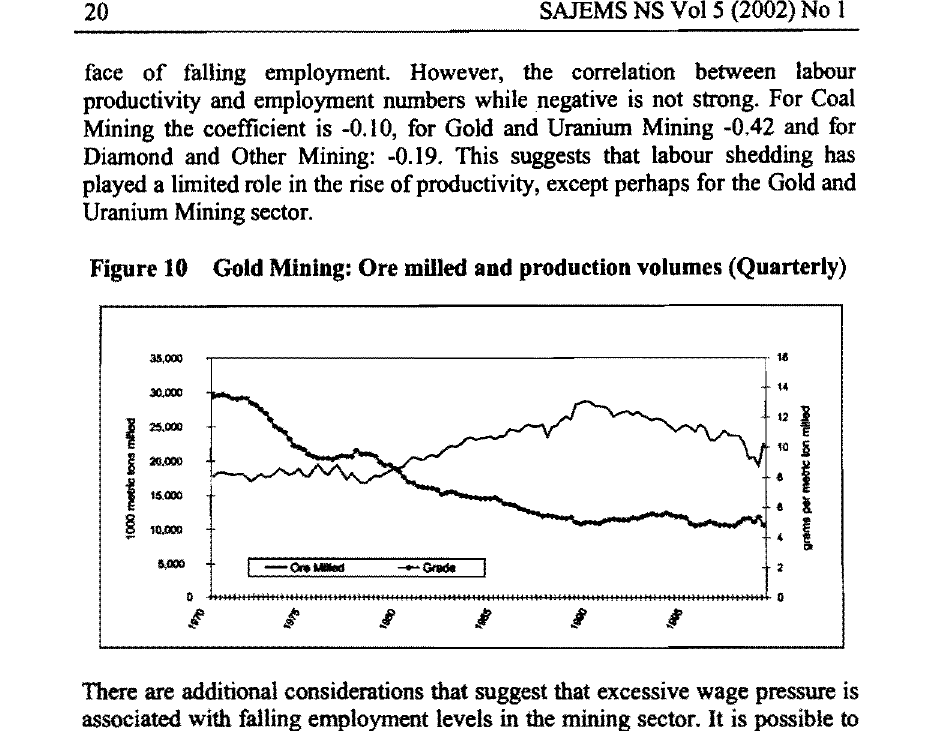
Figure 10 Gold Mining: Ore milled and production volumes